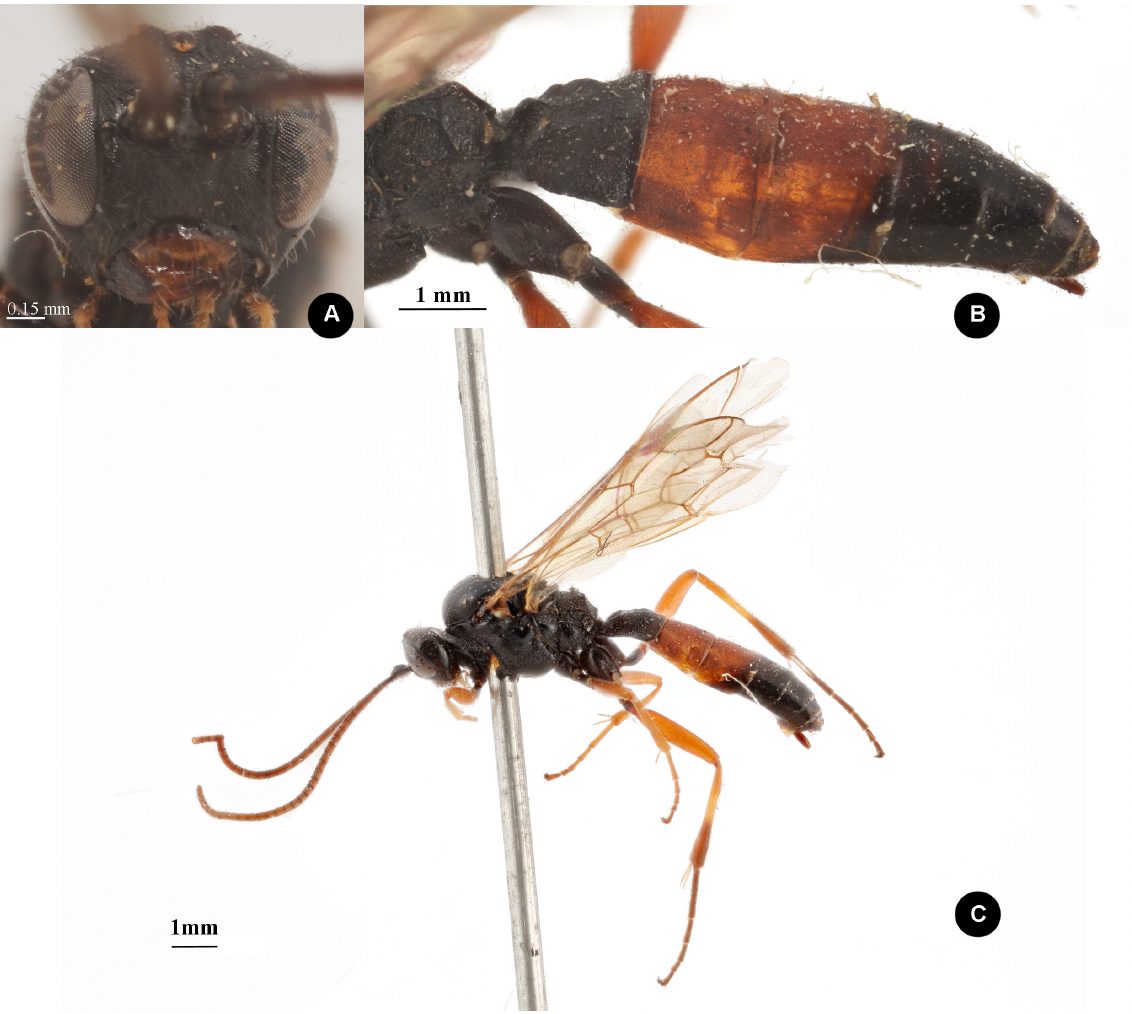
Fig. 9. Rhinotorus mesocostanus (Thomson, 1894). A . Face. B . Metasoma. C .